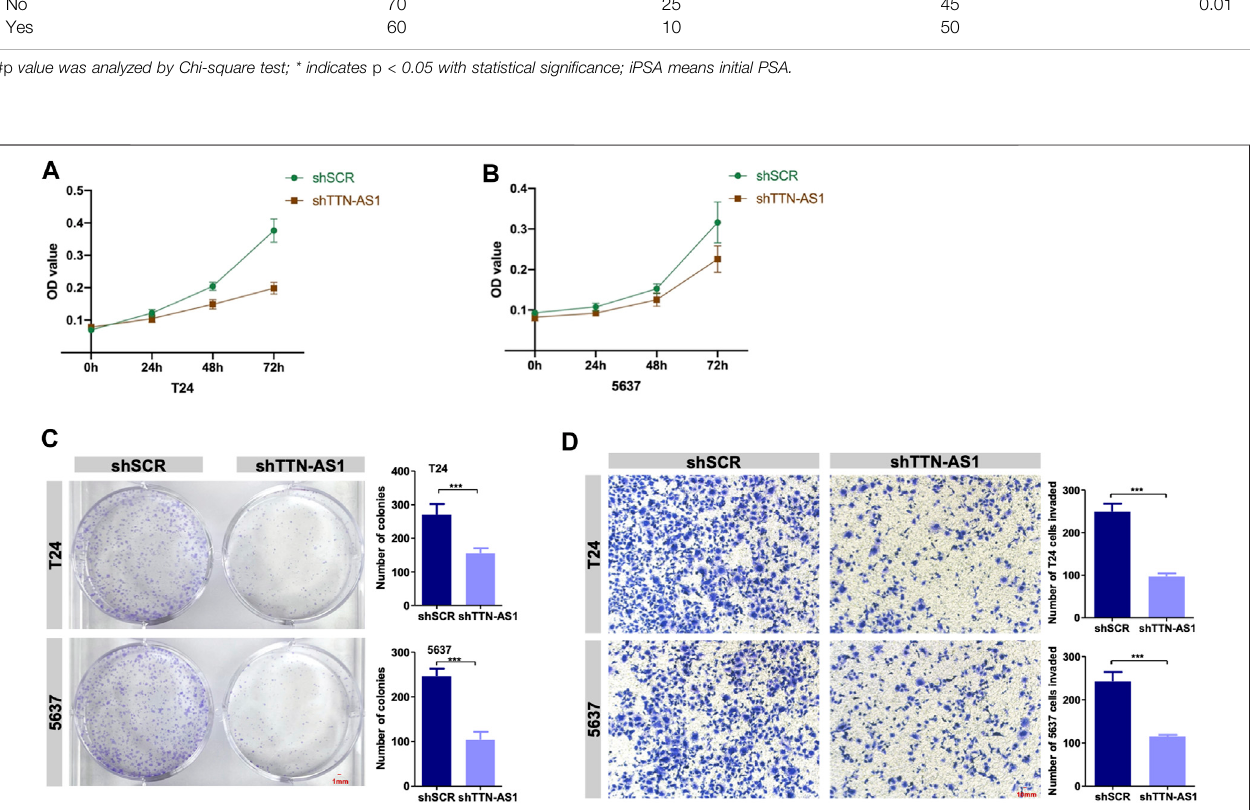
Frontiers in Genetics |